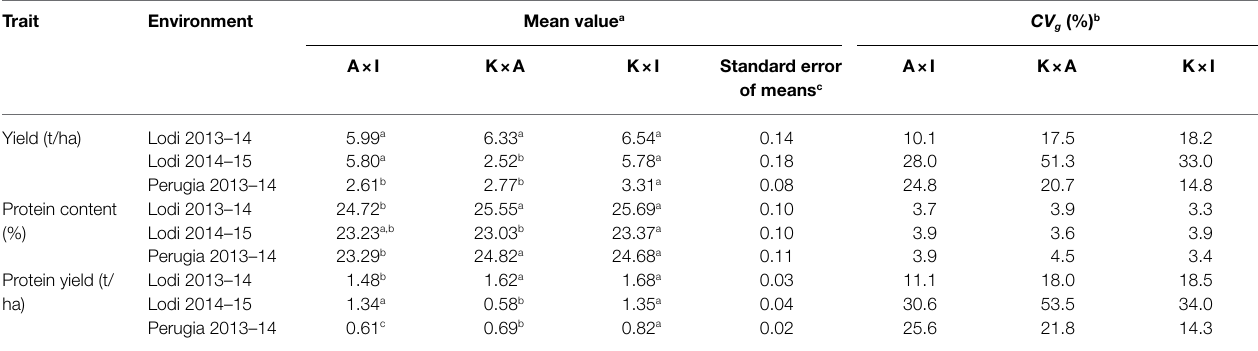
TABLE 2 | Mean value and genetic coefficient of variation of three traits measured in three test environments on pea lines of three RIL populations derived from connected crosses (A × I, 102 lines; K × A, 100 lines; K × I, 104 lines).